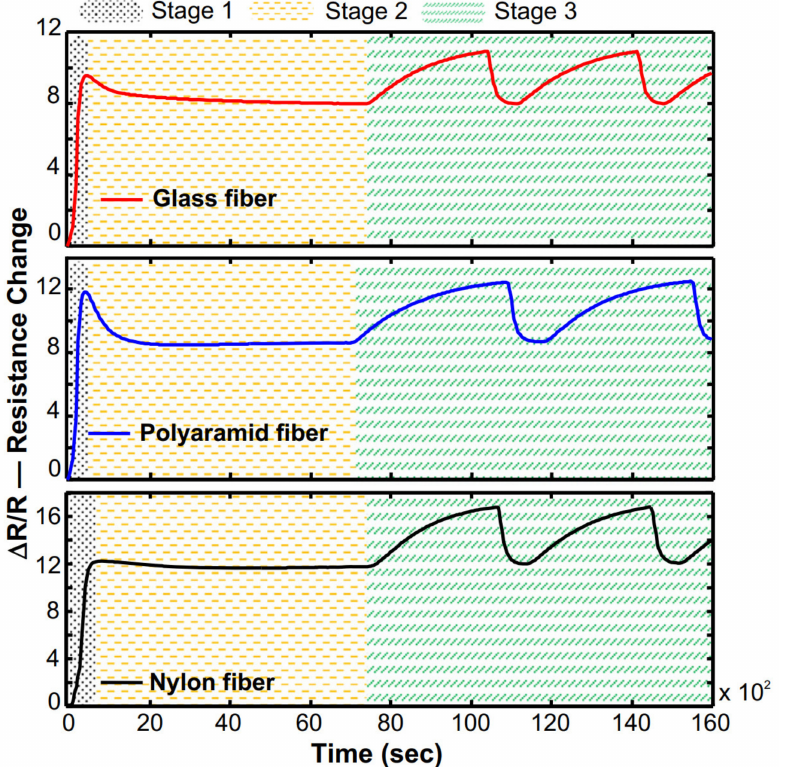
Figure 11. Resin curing process of the epoxy/glass fiber composite registered by the real-time resistance change of different types of SWCNT-FibSen sensors (glass, polyaramid and nylon). Stage 1: temperature ramping from 25 to 143 ◦ C; Stage 2: isothermal at 143 ◦ C for 2 h; Stage 3: cyclic thermal aging—cooling from 143 to 30 ◦ C and reheating from 30 to 143 ◦ C twice